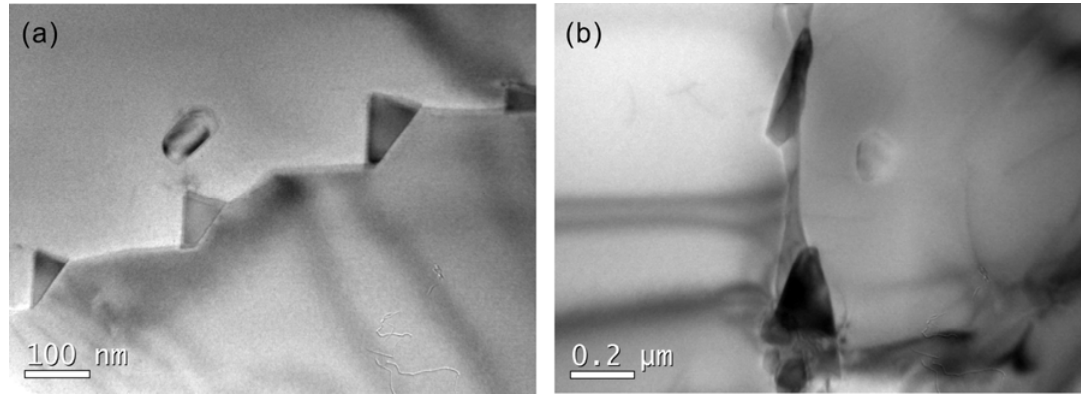
Figure 2. Typical TEM morphology of the precipitates: ( a ) granular and ( b ) lamellar.